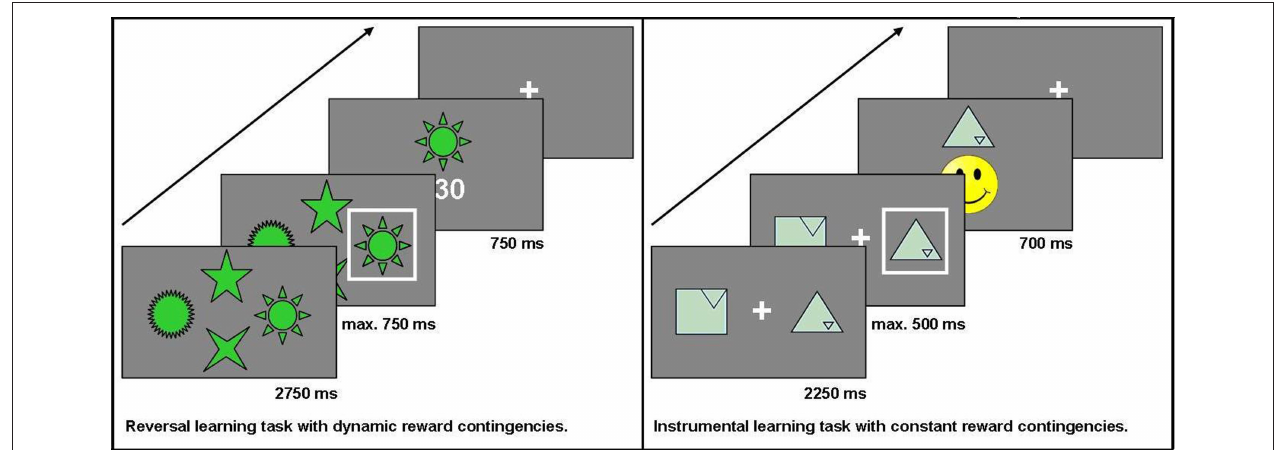
FiGure 1 | Setup of the two reward-based learning